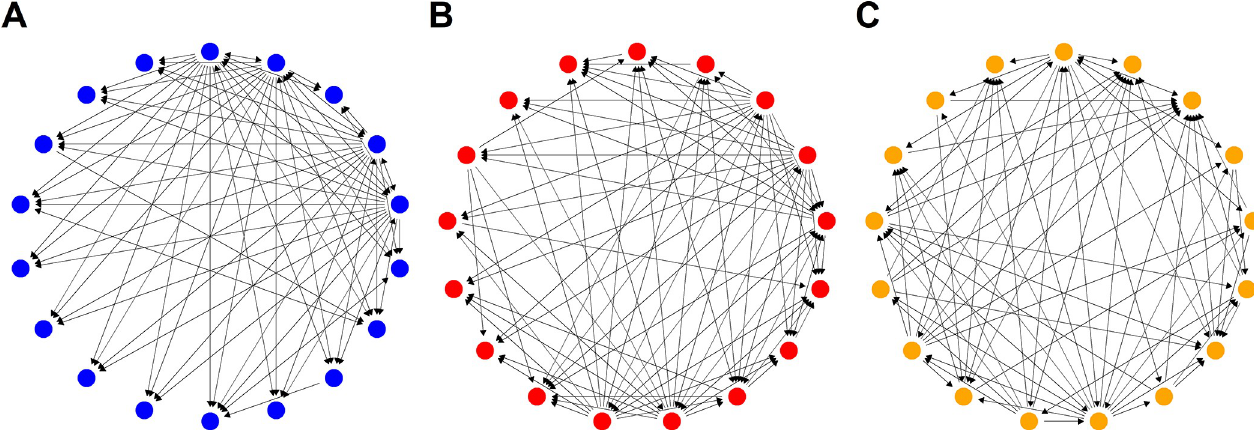
Fig 1. Networks of inhibitory interactions among Streptomyces isolates from different locations (designated ‘A’ [blue], ‘B’ [red], and ‘C’ [orange]). Nodes represent isolates whereas directed edges indicate antibiotic inhibitory interactions among isolates.